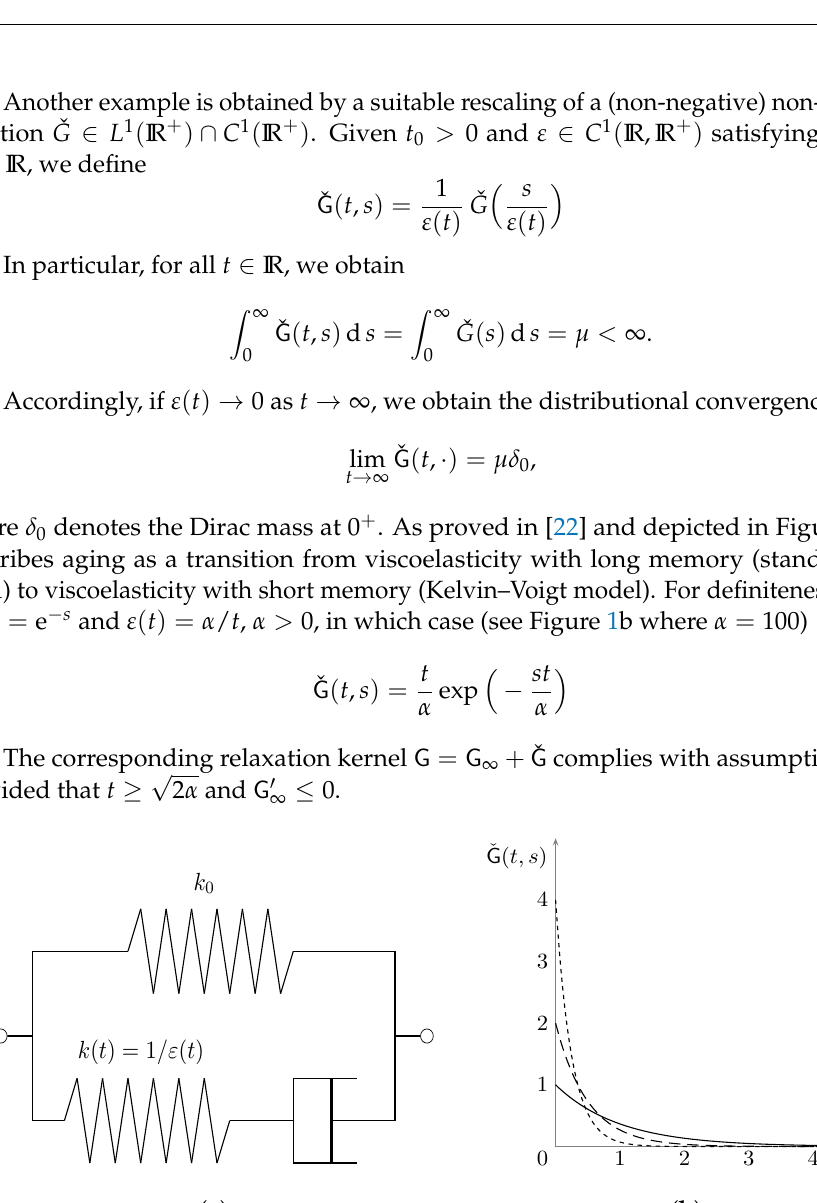
( a ) Figure 1. Standard solid model Here t = 100 s (solid), t = 200 s (dashed), t = 400 s (short dashed), Figure 1. ( a ) The standard solid model with an aging spring component. ( b ) Plot of the memory kernel ˇ G at t = 100s (solid), t = 200s (dashed), t = 400s (short